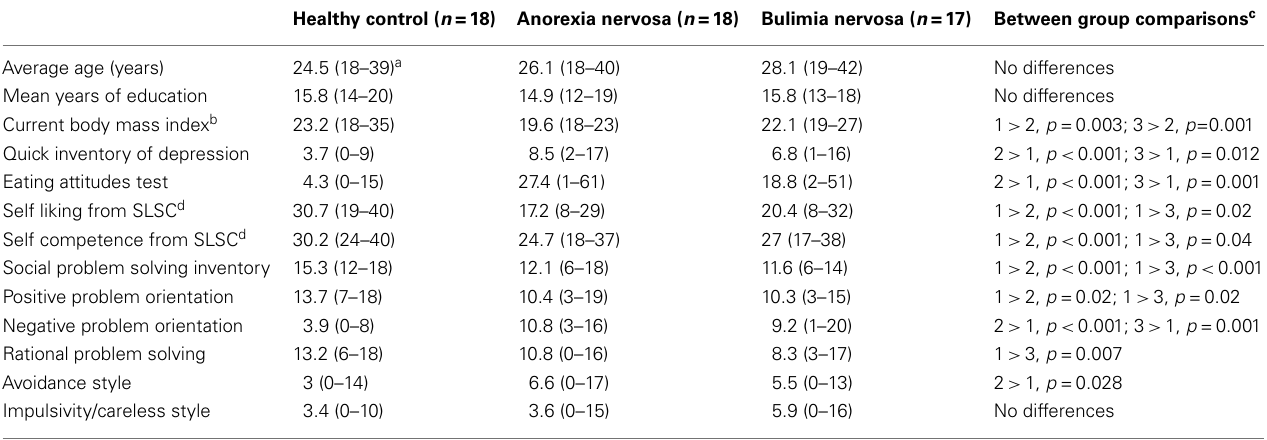
Table 1 | Sociodemographic and symptom scale values for the